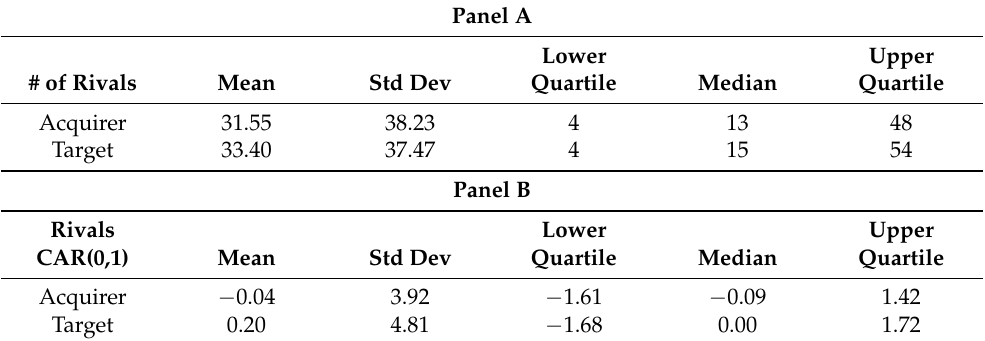
Table 3. Summary of